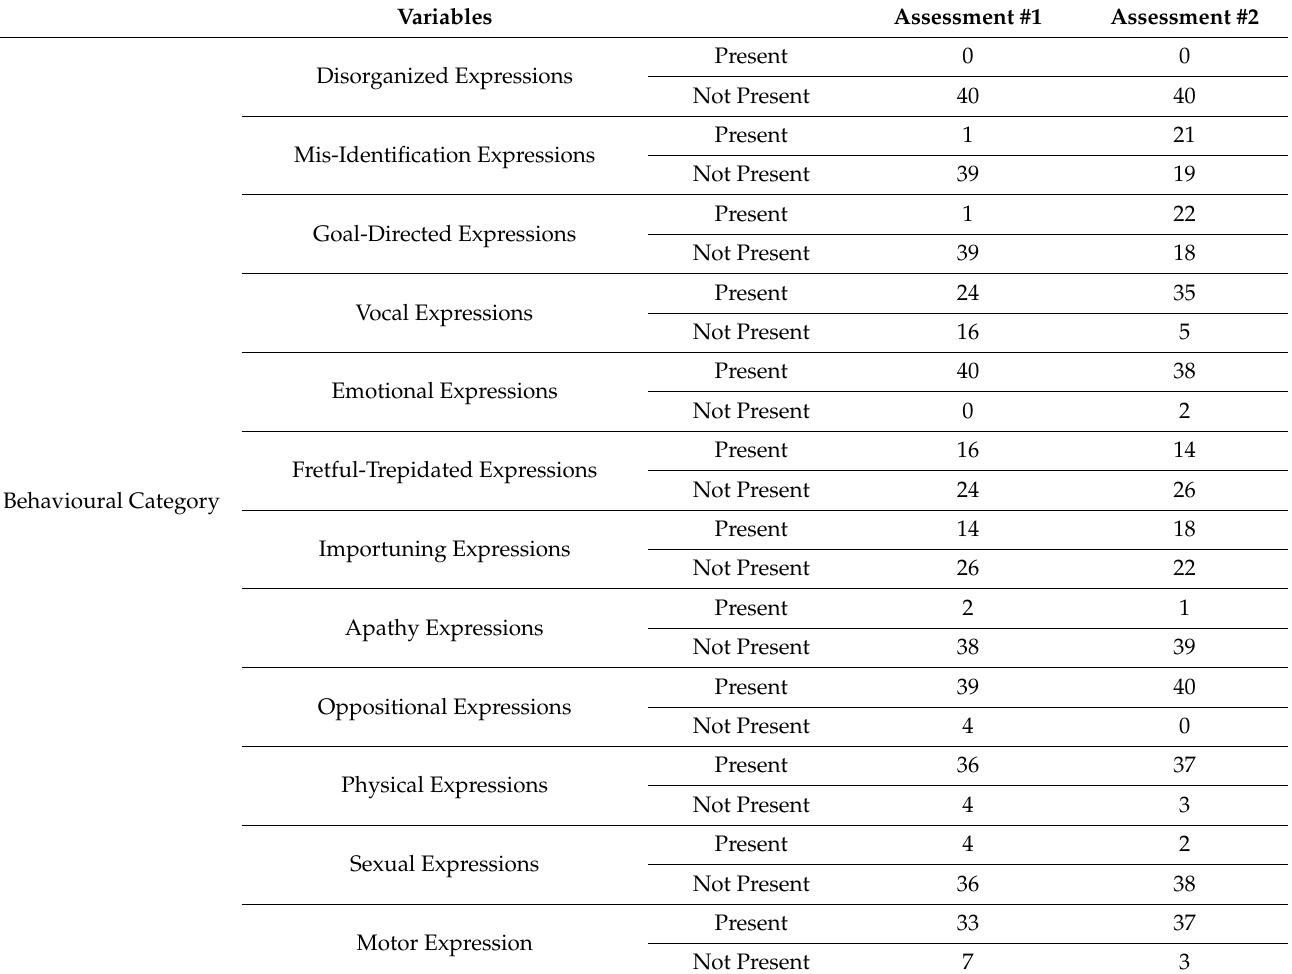
Table 4. Shows Behavioral Frequencies by Category and Assessment.